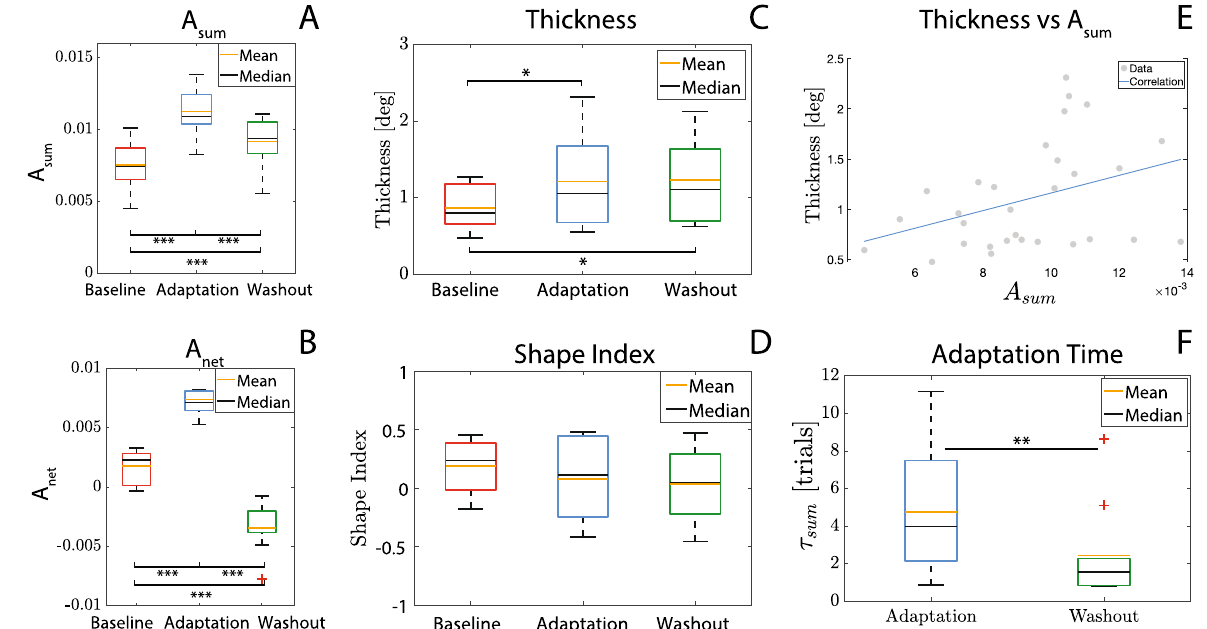
Figure 6. ( A – D ) Performance parameters averaged along trials and participants in baseline, adaptation and washout phases. ( A ) A sum ; ( B ) A net ; ( C ) thickness; ( D ) Shape Index; ( E ) correlation between thickness and A sum . ( F ) Adaptation time τ sum averaged along trials and participants in adaptation and washout